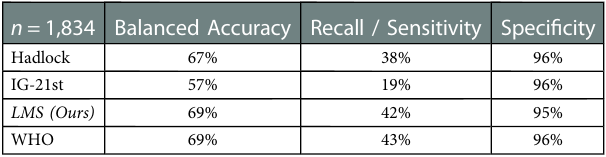
TABLE 3 Result of different fetal growth reference charts in predicting SGA at birth.